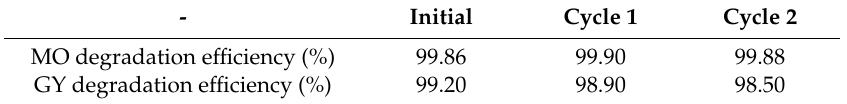
Table 3. Reusability cycles in the photodegradation of MO and GY, using 2%C-TiO 2 -CFA / PAN.